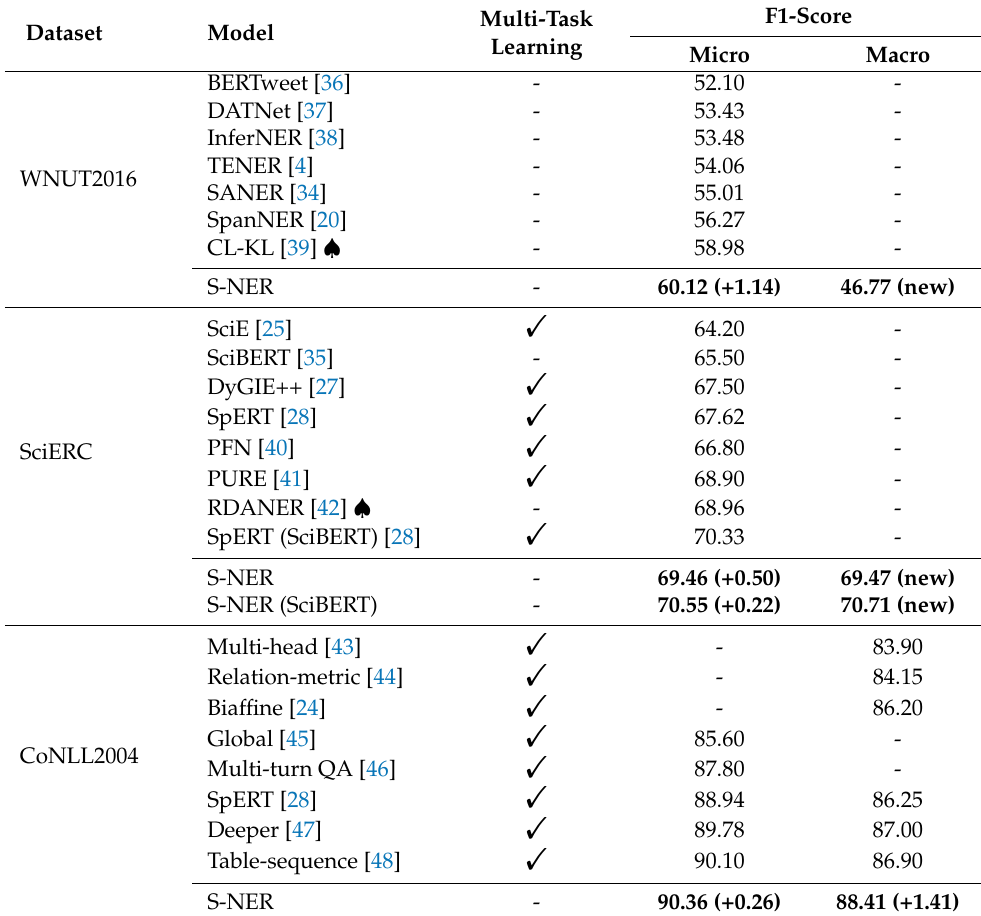
Table 1. Main results on the test sets of benchmarks. ♠ : using extra data resources such as gazetteer. Bold values denote the best